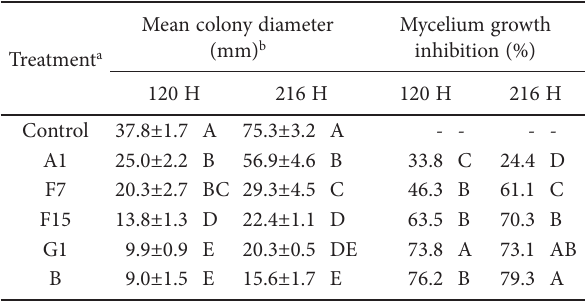
Table 3. Activities of bacterial seed endophytes on growth of Fusar- ium culmorum mycelium, after 120 and 240 h incubation.